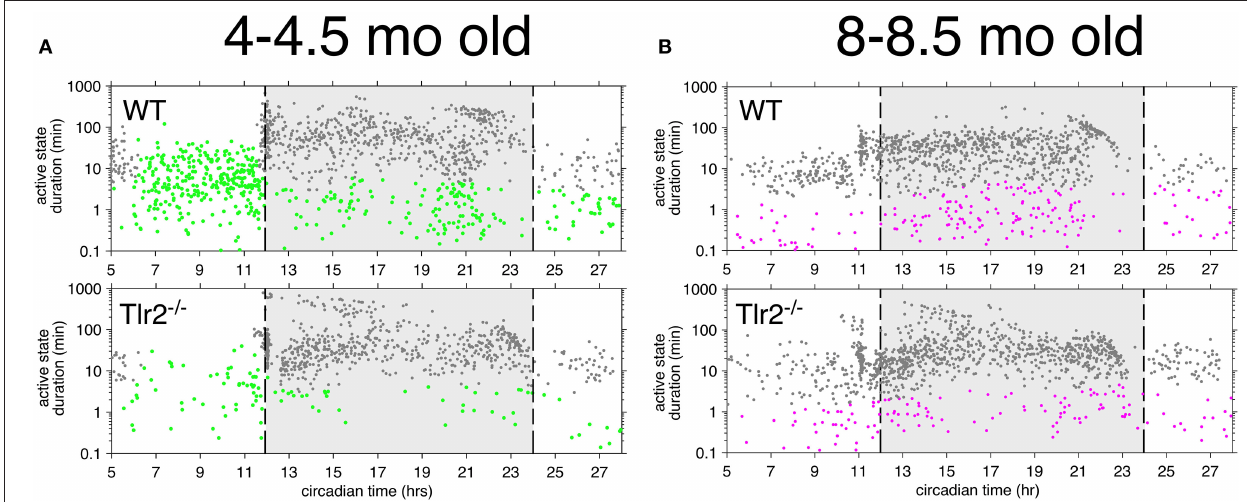
FIGURE 5 | Tlr2 − / − mice have fewer short duration active states throughout the circadian day (A) . 4–4.5 months old mice. Each point represents an active state from a WT (top left) or Tlr2 − / − (bottom left) mouse within the cohort over the total experimental duration. x axis depicts active state onset time, y axis depicts active state duration (in log). Dashed lines depict onset (left) and offset (right) of the dark cycle, which is further highlighted in light gray. Active states highlighted in green depict regions where states with these specific onset/duration properties are statistically overrepresented in wildtype mice and underrepresented in Tlr2 − / − mice. Note that for 4–4.5 months old mice, these states include shorter duration active states throughout the circadian day, as well as all duration active states for the last half of the light cycle (B) . 8–8.5 months old mice. Each point represents an active state from a WT (top right) or Tlr2 − / − (bottom right) mouse. Plot annotations otherwise per (A) . Active states highlighted in violet depict regions where states with these specific onset/duration properties are statistically overrepresented in wildtype mice and statistically underrepresented in Tlr2 − / − mice. For 8–8.5 months old mice, these states include shorter duration active states throughout the circadian